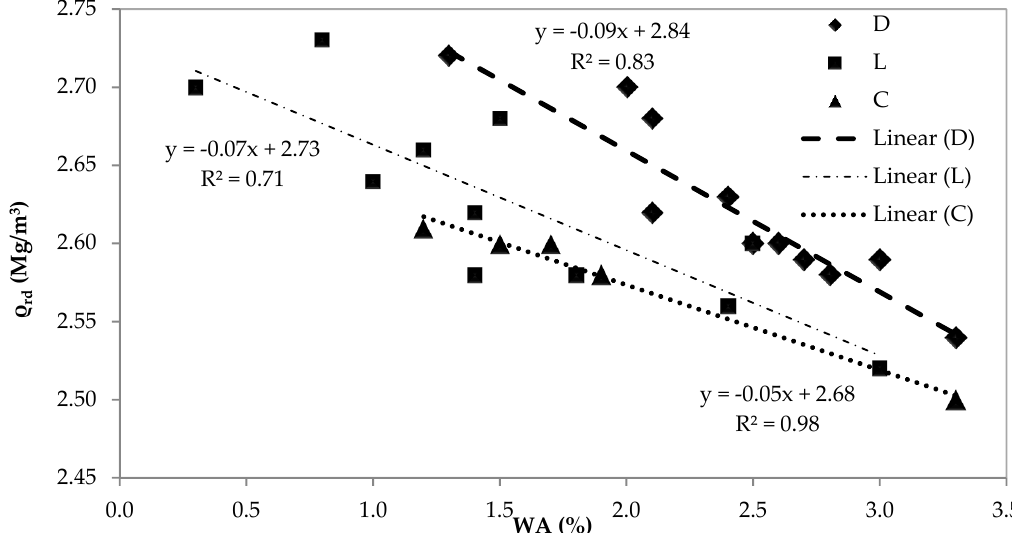
Figure 6. Correlation between water absorption (WA) and oven-dried particle density ( ρ rd ) (D: Diabase/Basalt, L: Reef Limestone, C: Calcarenite Limestone).